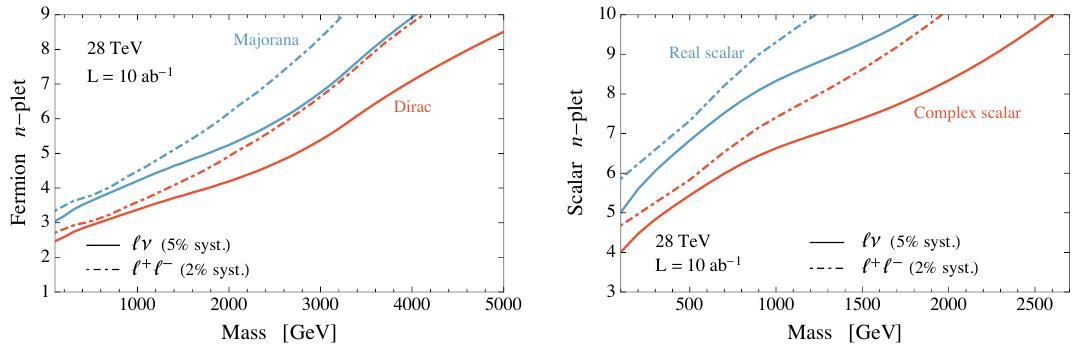
Figure 5 . Expected 95% CL exclusion limits obtained for the HE-LHC.